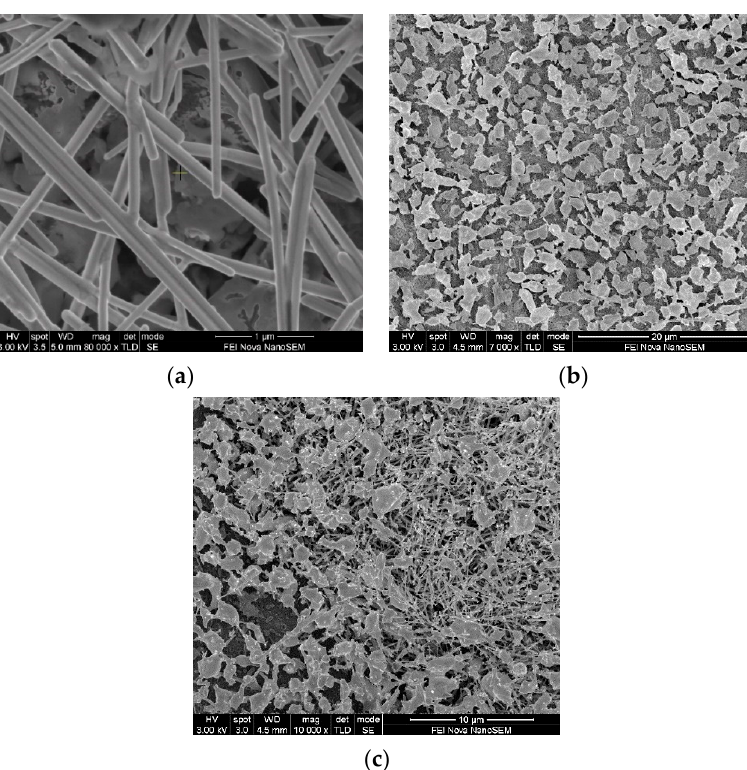
Figure 3. SEM images of AgNW-modified aluminium surfaces ( a ) single-stage deposition at 300 °C, ( b ) single-stage deposition at 375 °C and ( c ) two-stage deposition (375 °C followed by 300 °C).